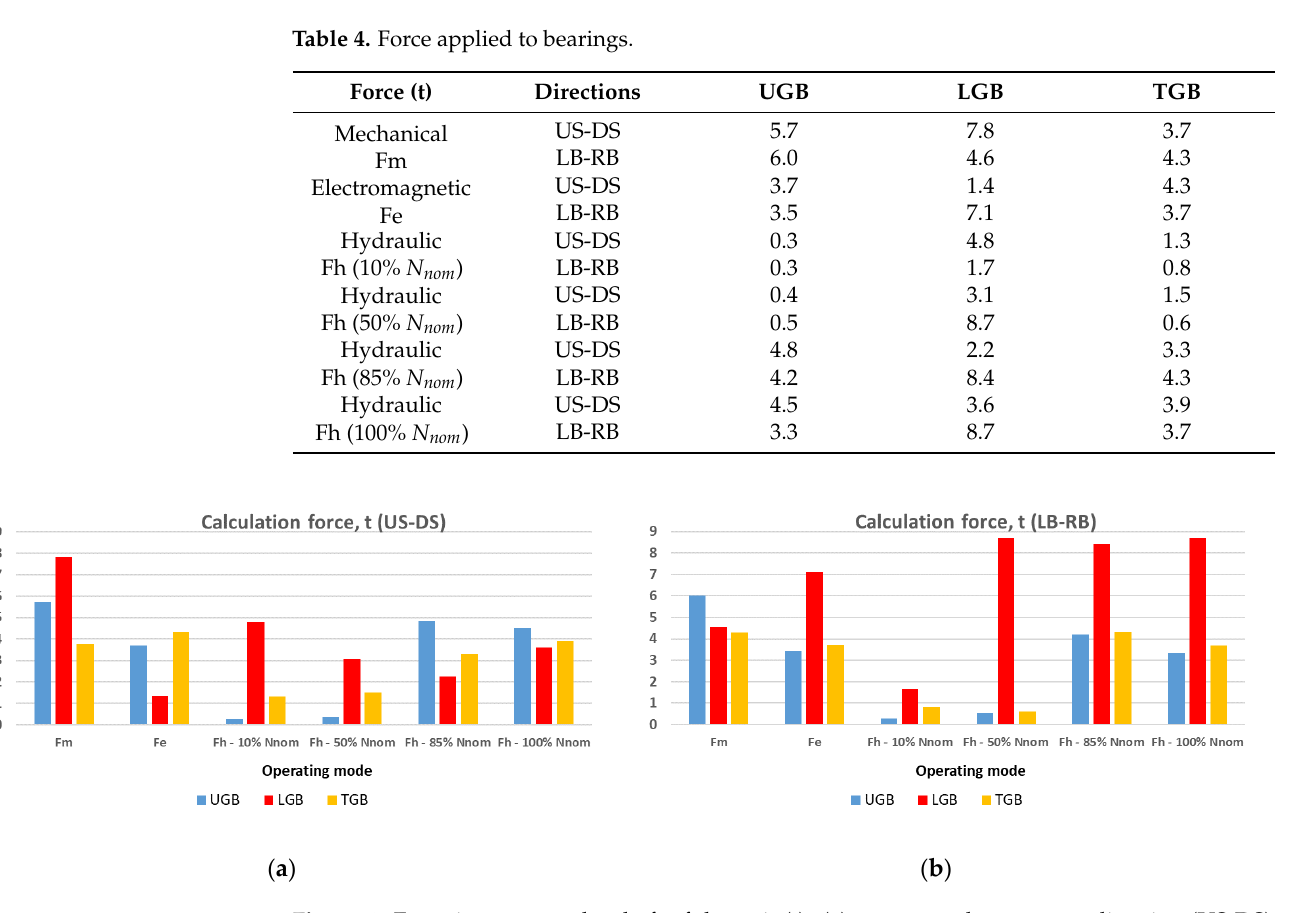
description of the modes is given in Section 3).